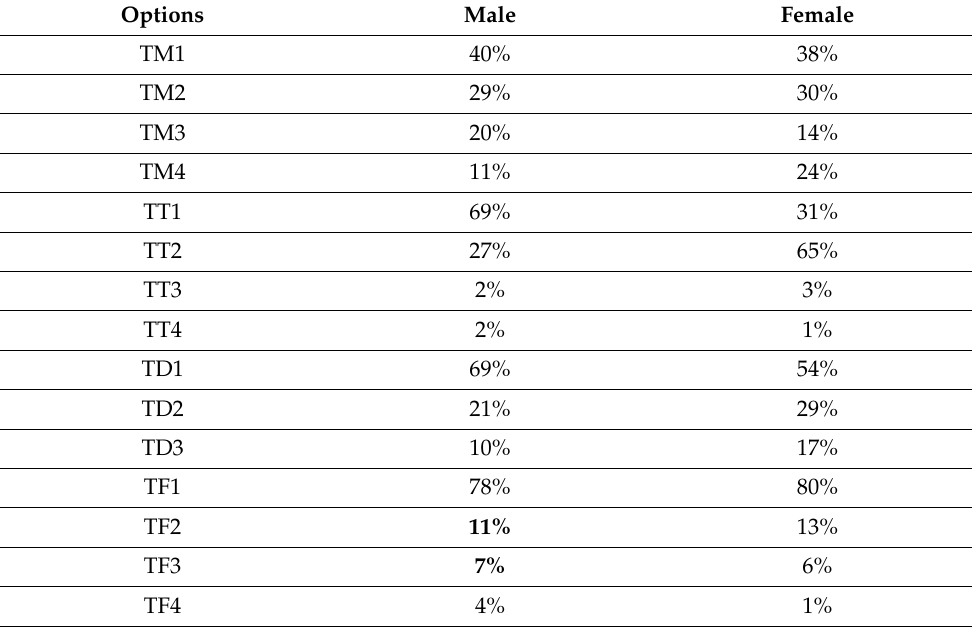
Table 3. Priorities of TBCs from the lens of gender